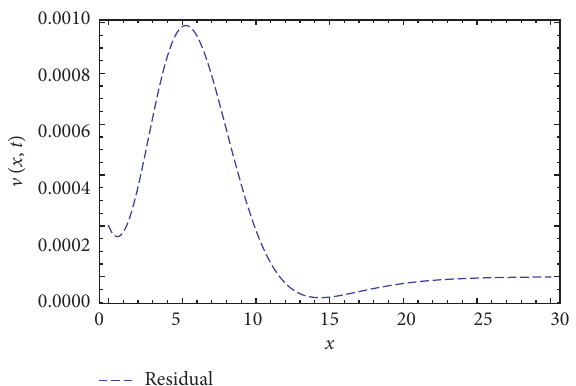
Figure 2: Residual of ξ ( η ,t ) by OHAM-DJ at t � 0 . 1.